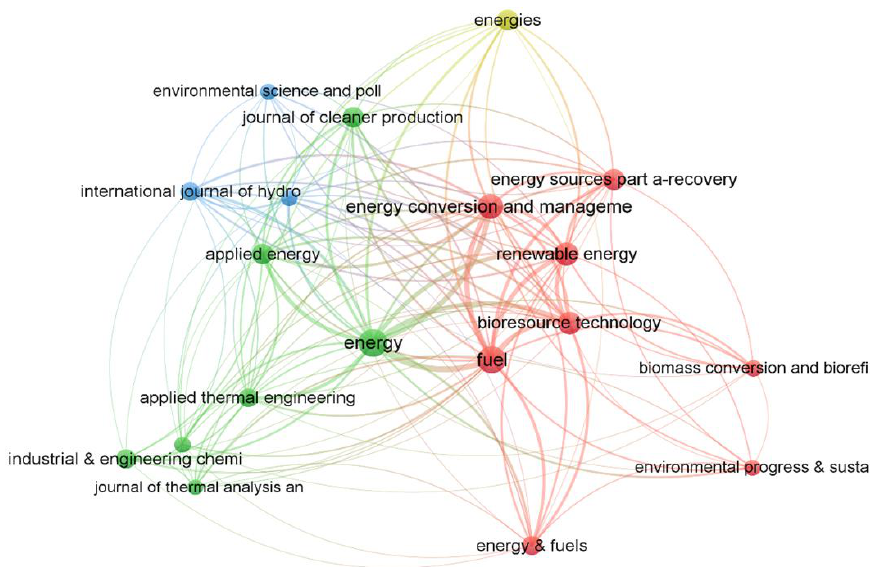
Figure 9. Citation map analysis displaying the collaboration between journals publishing AI in bioenergy research. The size of each node represents the number of publications published. The lines in between each node represent one journal citing from another.